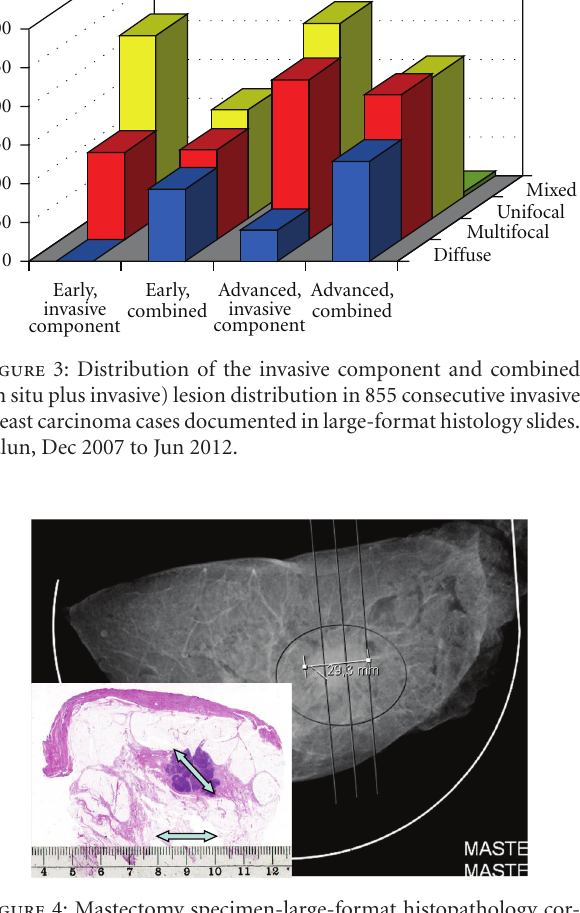
Figure 4: Mastectomy specimen-large-format histopathology cor- relation: unifocal invasive cancer. The plane of slicing the mas- tectomy specimen was erroneously chosen, which resulted in a discrepantly smaller tumor size in the histology slide compared with the mammographic size of the specimen. The specimen mammography image is courtesy of Dr. Mats